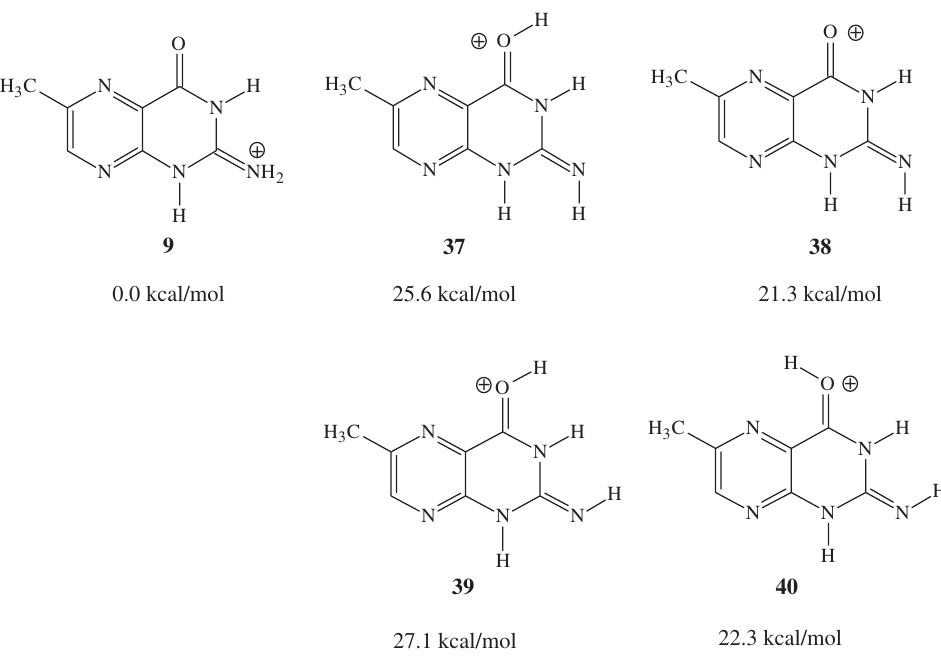
Figure 11 Relative calculated energies of pterins resulting from the non-ring protonation of the two guanidinyl lactam structures, 5 (top) and 6